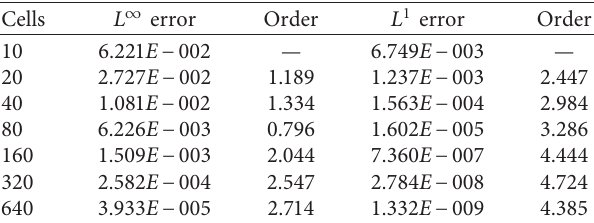
Table 2: Example 1, ε � 0 . 01, numerical errors and orders of convergence at t �